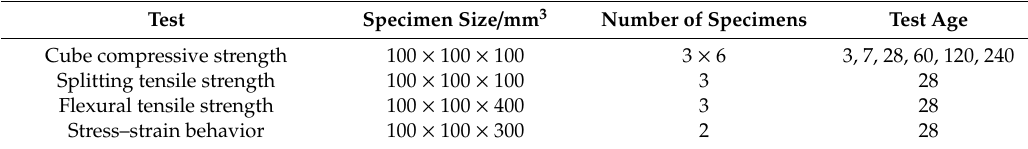
Table 6. Test item and specimen dimensions for each concrete